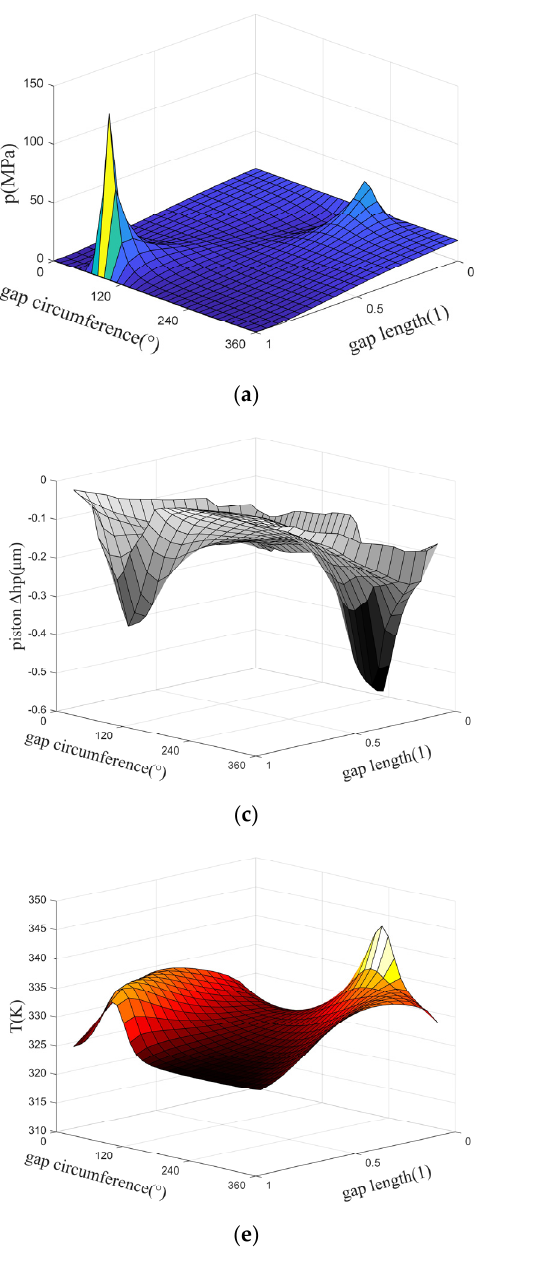
Figure 5. Pressure field, elastic deformation, and temperature field: ( a ) Predicted by the fluid model; ( b ) predicted by the fluid–structure–thermal interaction model; ( c ) the elastic deformation of the piston’s surface; ( d ) the elastic deformation of the bushing’s surface; ( e ) the temperature distribution of the film; and ( f ) the dynamic viscosity distribution of the